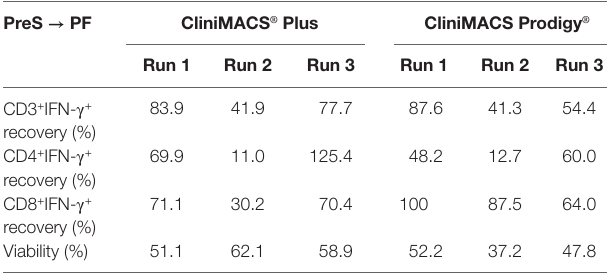
tABLe 3 | Comparative findings of both Plus and Prodigy process runs for the separations of CMV-specific t-cells. Pres →